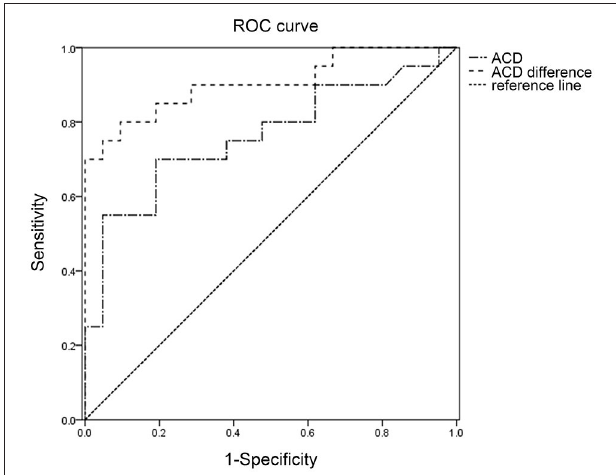
FIGURE 2 | The receiver operating characteristic (ROC) curve for ACD and ACD difference, in relation to the diagnosis of ASAC-LS. ROC, Receiver operating characteristic; ACD, anterior chamber depth; ASAC-LS, acute secondary angle closure associated with lens